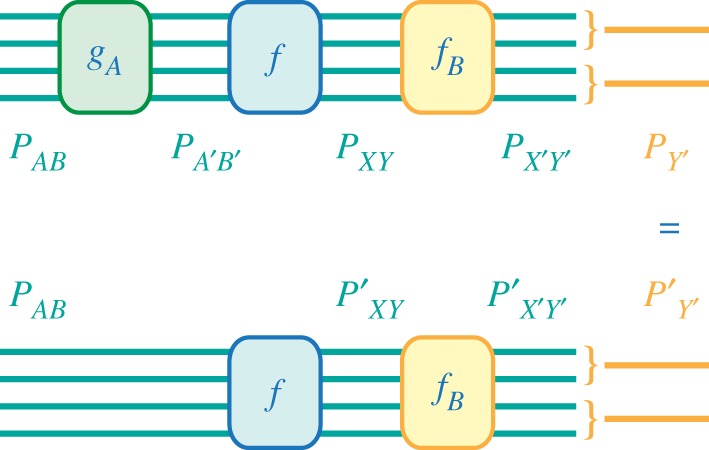
Extended secrecy in GPTs. Consider two agents Alice and Bob and a two-bit random variable AB (the four possible outcomes are represented by vertical lines). Our global state space consists of distributions over two bits (whose names we change after each step to make a proof more readable). Let the reduction to the state space of Bob be a coarse-graining over the first bit, PY(y)=PXY(0,y)+PXY(1,y), as shown on top. Secrecy in the presence of a function f (equation (1)) corresponds to PY ′=P′Y ′ in the diagram. This is satisfied, for example, if f represents the use of a PR-box, while gA and fB correspond to choices of inputs and post-processing: Bob cannot guess Alice’s choice of input after the use of a PR-box. This is equivalent to the traditional notion of non-signalling [17] applied to the PR-box. (Online version in colour.)